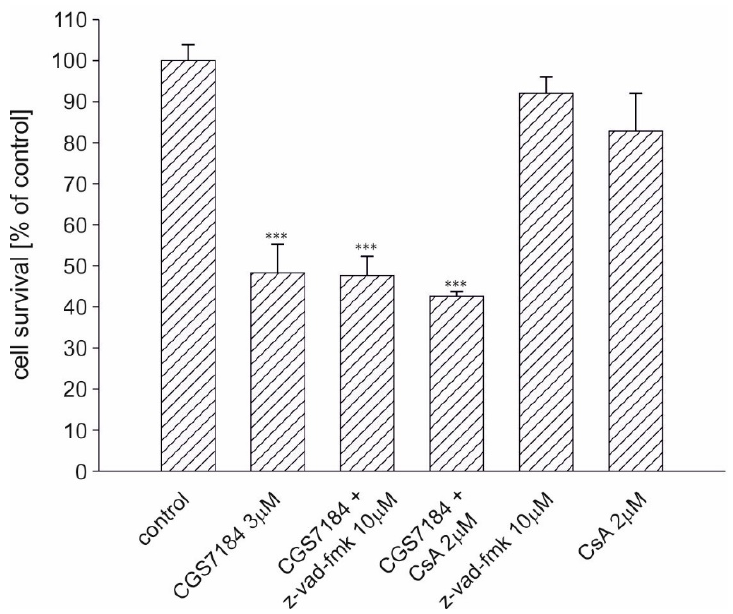
Figure 6. Toxicity induced by CGS7184 is not diminished by the inhibitor of PTP (CsA) or caspases (z-vad-fmk). HT22 cells were treated with the potassium channel opener CGS7184, the inhibitor of PTP (CsA) or caspases (z-vad-fmk) added alone or in combinations. Cell survival was measured using the MTT assay 18 h after insult. All data are expressed as means ± SEM from three independent experiments with three replicates per data point. *** p < 0.001 vs. control by one-way ANOVA followed by Tukey’s test.